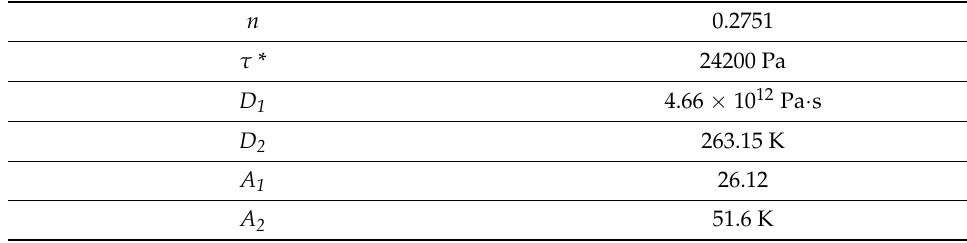
Table 1. Coefficients of Cross-WLF model for a generic PP [29].